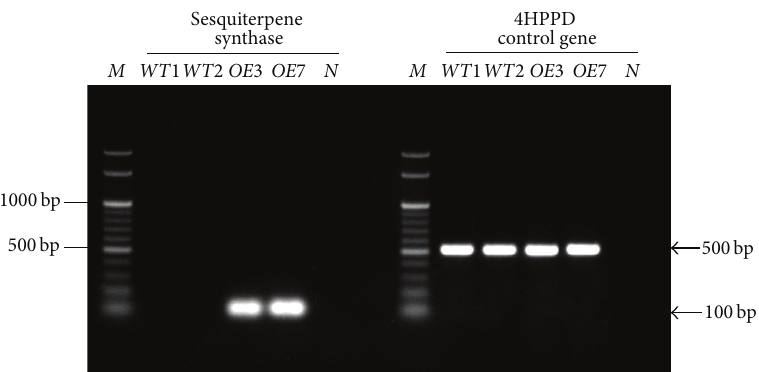
Figure 6: Semiquantitative RT-PCR for sesquiterpene synthase ( PmSTS ). PCR for the 4HPPD gene was performed in parallel as a positive control. M: 100bp DNA ladder; WT 1 and WT 2: wild type A. thaliana plants; OE 3: OE 3 transgenic plant; OE 7: OE 7 transgenic plant; N : no template control.